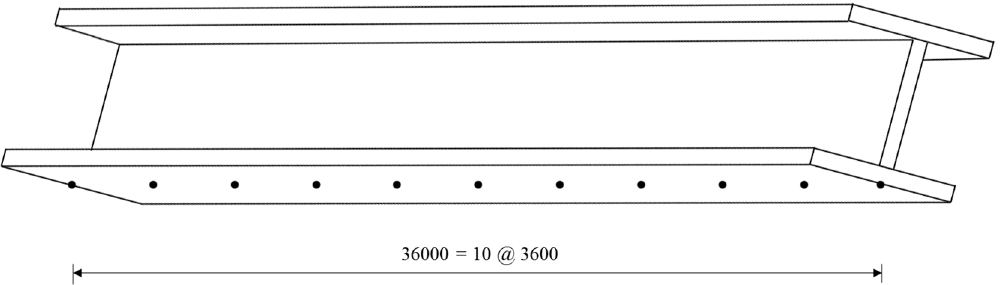
Figure 6. Example of vehicle distribution scenario for 60 km/h (unit: m).